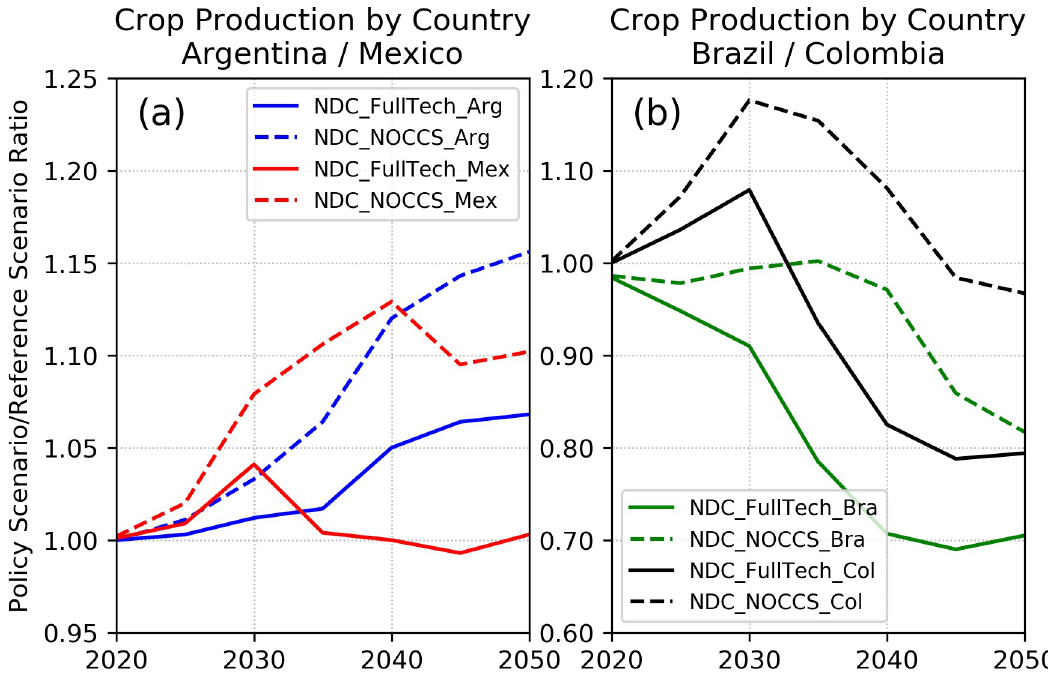
Fig 5. Crop production by country expressed as the ratio between each NDC scenario and the reference scenario. For each country, the amount of agricultural production only includes those crop categories in which a share of their total production is under irrigation. This means that the amount of crop production accounted in this figure does not reflect the total crop production calculated by GCAM for each country.